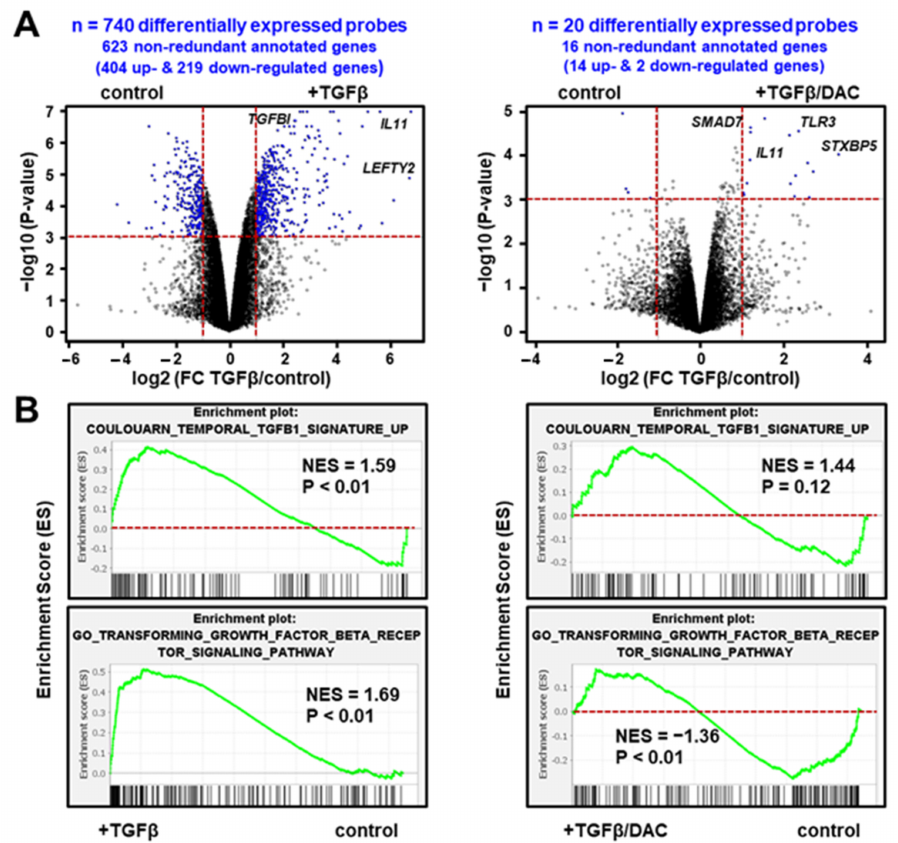
Figure 1. Decitabine impairs the transcriptional response of SNU449 HCC cells to TGF β . ( A ) Volcano plot highlighting differentially expressed probes (blue dots) in SNU449 cells treated with TGF β (16 h) in the absence (left panel) or presence (right panel) of decitabine (DAC). Probes were selected based on the significance of the differential expression in the experimental conditions (horizontal red line; p < 0.001) and the level of induction or repression (vertical red lines; fold change >2). In total, 740 probes were differentially expressed upon TGF β treatment in the absence of DAC, but only 20 probes in the presence of DAC, using the same selection criteria. ( B ) Gene set enrichment analysis (GSEA) using the gene expression profiles of SNU449 cells treated with TGF β in the absence (left panels) or presence (right panels) of decitabine. Shown are the enrichment plots of two curated TGF β -associated gene expression signatures. NES: Normalized Enrichment